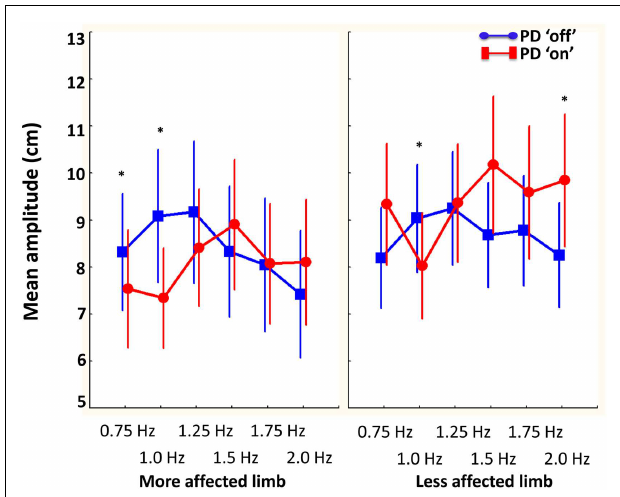
FIGURE 5 |The influence of dopamine replacement on mean amplitude (cm) of the more and less affected limb in PD participants across cycle frequencies . Results demonstrated that PD “on” had larger amplitude movements at the faster cycle frequency in the less affected limb. However, PD “off” had larger amplitude movements in the more and less affected limb at slower cycle frequencies (0.75–1 and 1Hz, respectively) (bars denote standard error). *Denotes significant differences between PD “off” and PD